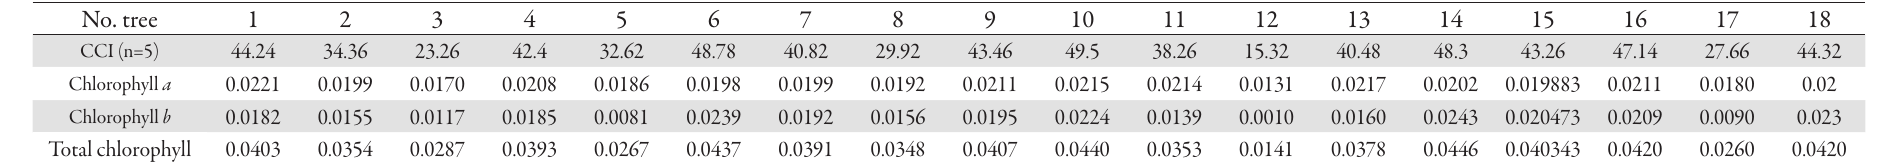
Tab. 1. Chlorophyll a (mg/cm -² ), Chlorophyll b (mg/cm -2 ), total chlorophyll content (mg/cm -2 ) and CCM readings in leaves of Asian pear trees No. tree